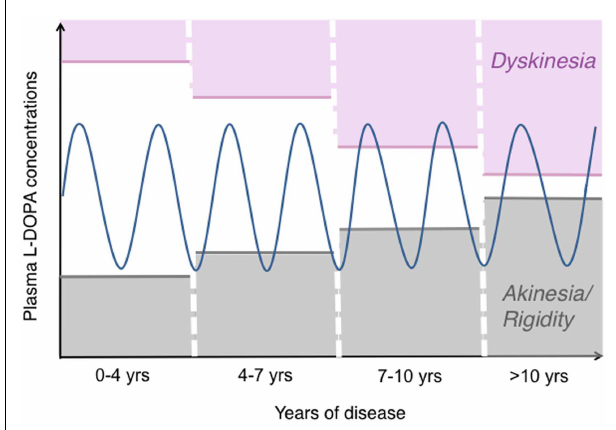
FIGURE 1 |The pattern of motor response to L -DOPA changes during the progression of PD .This drawing illustrates how the therapeutic window of L -DOPA narrows during the progression of PD [based on (172, 173)].While oral L -DOPA therapy achieves a stable symptomatic control during the first years, it causes motor fluctuations and dyskinesias in more advanced disease stages. Dyskinesias are most commonly associated with high plasma levels of L -DOPA (peak-dose LID), as shown here.The blue sinuous line represents peaks-and-troughs in plasma L -DOPA levels concomitant with oral L -DOPA therapy.The empty area at the centre represents the range of L -DOPA concentrations that induce relief of PD motor features without causing